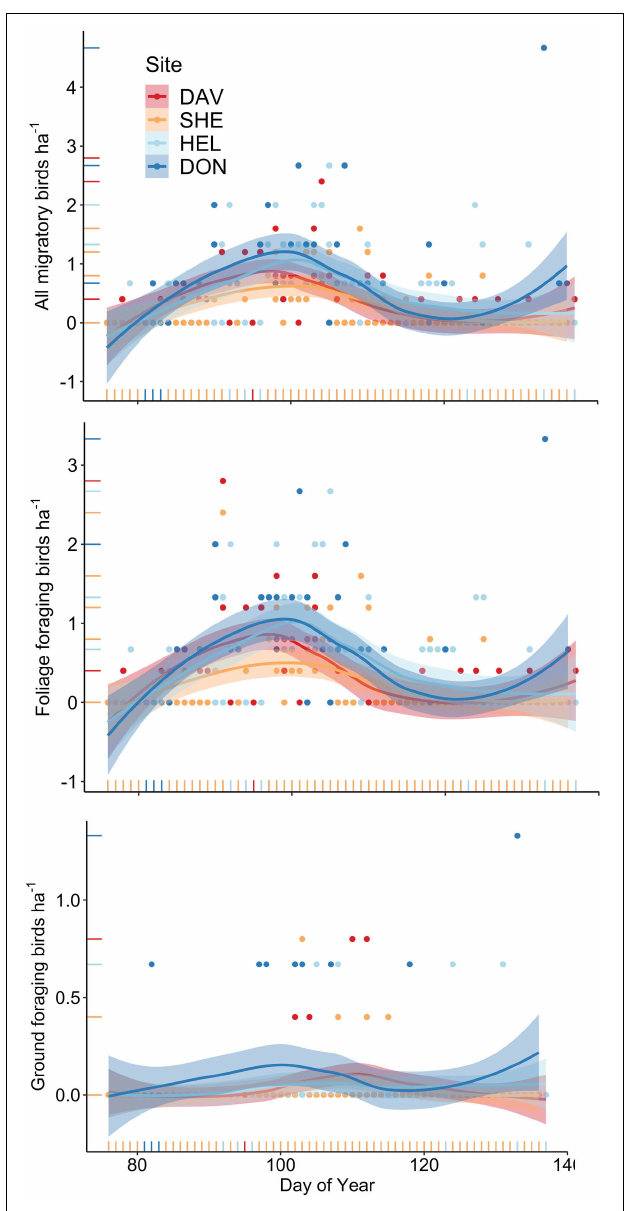
FIGURE 3 | Seasonal variability in the density of migratory birds and between foliage (canopy, sub-canopy, or understory) and ground foraging birds throughout spring migration (Day of Year 80 = 21 March) of 2011 and 2012 at two sets of paired large (red and orange) and small (light and dark blue) forested stopover sites in coastal Mississippi.